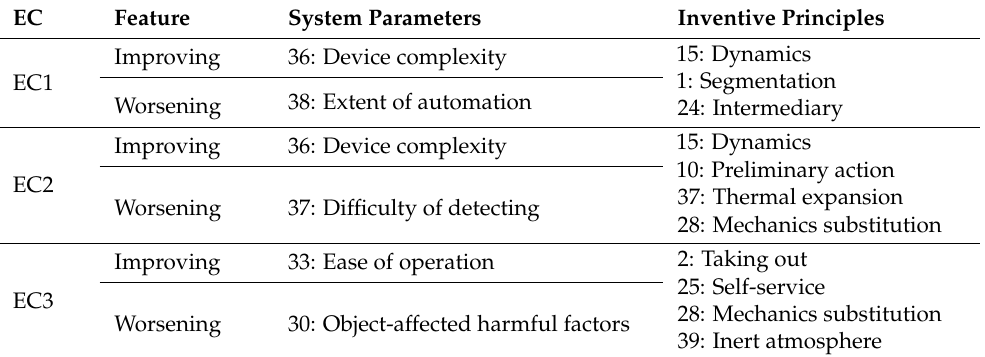
Figure 2. Segments of contradiction matrix where inventive principles are extracted according to identified system parameters. ( a ) Extracting inventive principles with system parameters #36 and #38; ( b ) Extracting inventive principles with system parameters #36 and #37; ( c ) Extracting inventive principles with system parameters #33 and #30. Table 3. Inventive principles extracted from the contradiction matrix to potentially resolve contra ‐ dictions.